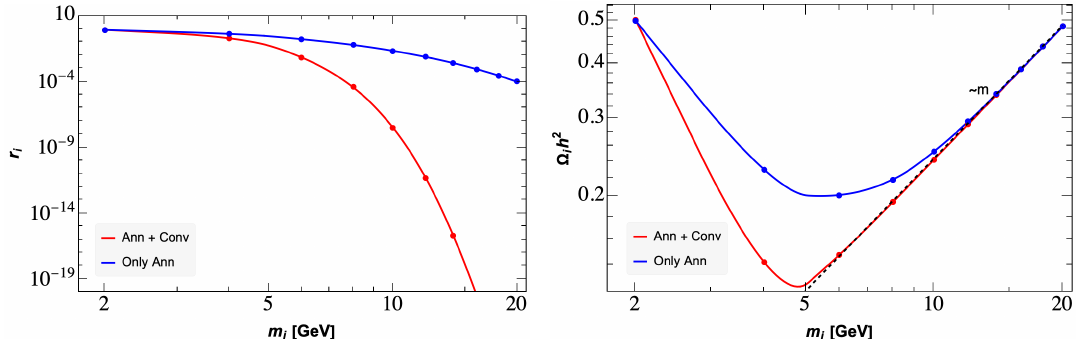
Figure 4 . Left panel: evolution of asymmetric ratios for 10 DM particles with m i − m i +1 = 2 GeV , m 1 = 20 GeV , h σv i = 2 pb and η i = η B , in presence (red) and absence (blue) of conversions. Right panel: the individual abundance of DM components versus mass in the asymmetric case. The black dashed curve depicts the direct proportionality to mass as particles become more asymmetric i.e. r 0 i →